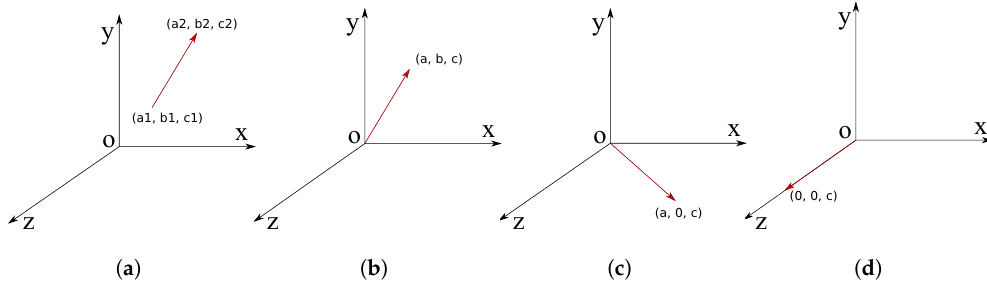
Figure A2. Illustration of rotation step along vectoral axes. A vector refers to a rotational axis in ( a ). ( b ) Translate the rotational axis to the origin coordinate. ( c ) Rotate on the rotational axis to the yoz plane. ( d ) Rotate on the rotational axis to coincide with the z axis. Then, the object can be rotated to angle θ on the z